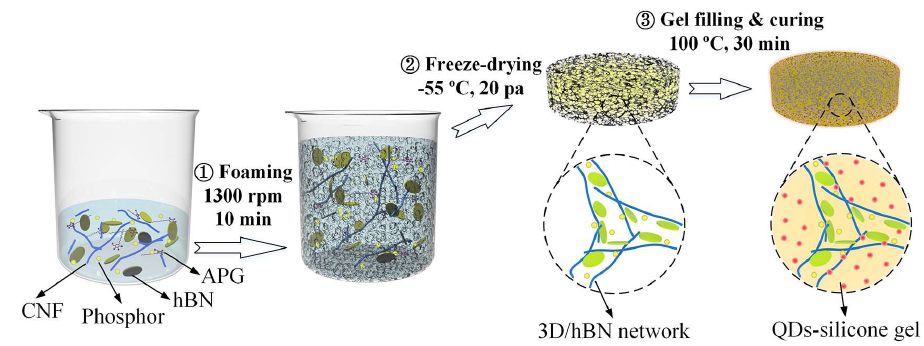
Figure 2. Schematic showing the fabrication process of 3D/hBN network and